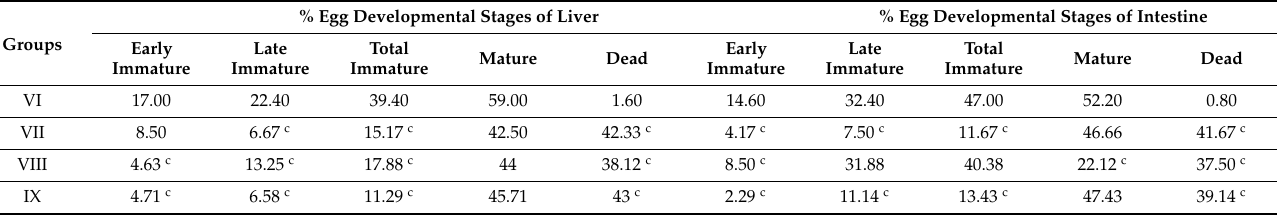
Table 3. Oogram pattern showing the percentage of S. mansoni ova at different stages of maturity in the liver and the intestine of infected mice after different treatment regimens (8 weeks